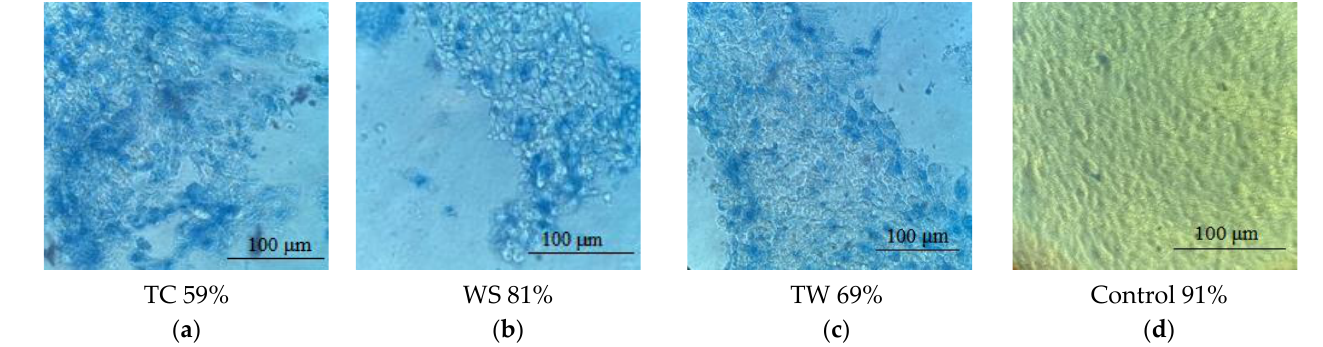
Figure 17. Optical images of the 3T3 cells after the interaction with the coatings and stained with trypan blue (blue — dead cells), cell viability (% of negative control): ( a ) TC, ( b ) WS, ( c ) TW, ( d ) control.